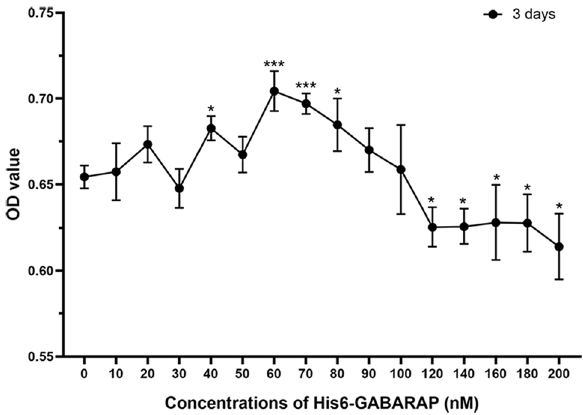
Figure 1. Edification the cytotoxicity of His6-GABARAP on BMSCs. MTT assay was applied after co-cultured with varying concentrations of His6-GABARAP for 3 days. Values are the means ± SD (* p < 0.05, *** p < 0.001 indicate the significant difference relative to the normal group, n =